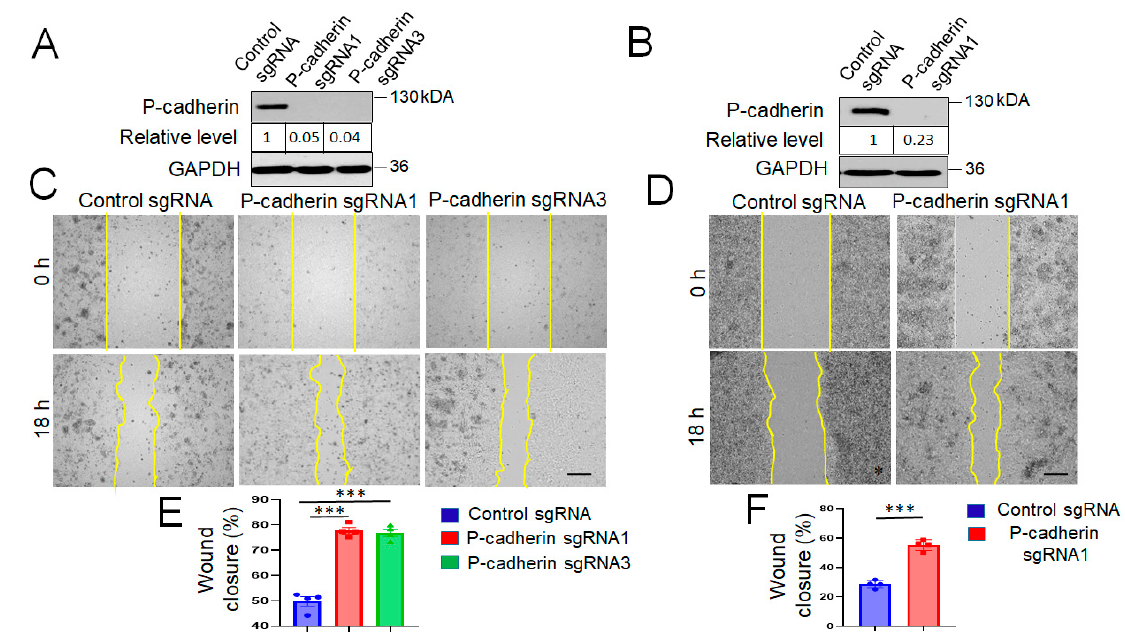
Figure 4. Knockout P-cadherin promotes intestinal epithelial cell migration: ( A , B ) Immunoblotting analysis shows the efficiency of CRISPR/Cas9-mediated P-cadherin knockout in HCA-7 and SK-CO15 cells. ( C , D ) Representative wound images and ( E , F ) quantification of cell migration at 18 h post-wounding in control and P-cadherin-depleted HCA-7 and SK-CO15 cell monolayers. Means ± SE ( n = 4); *** p < 0.005. Scale bars, 100 µ m. The results shown are representative of three independent experiments.